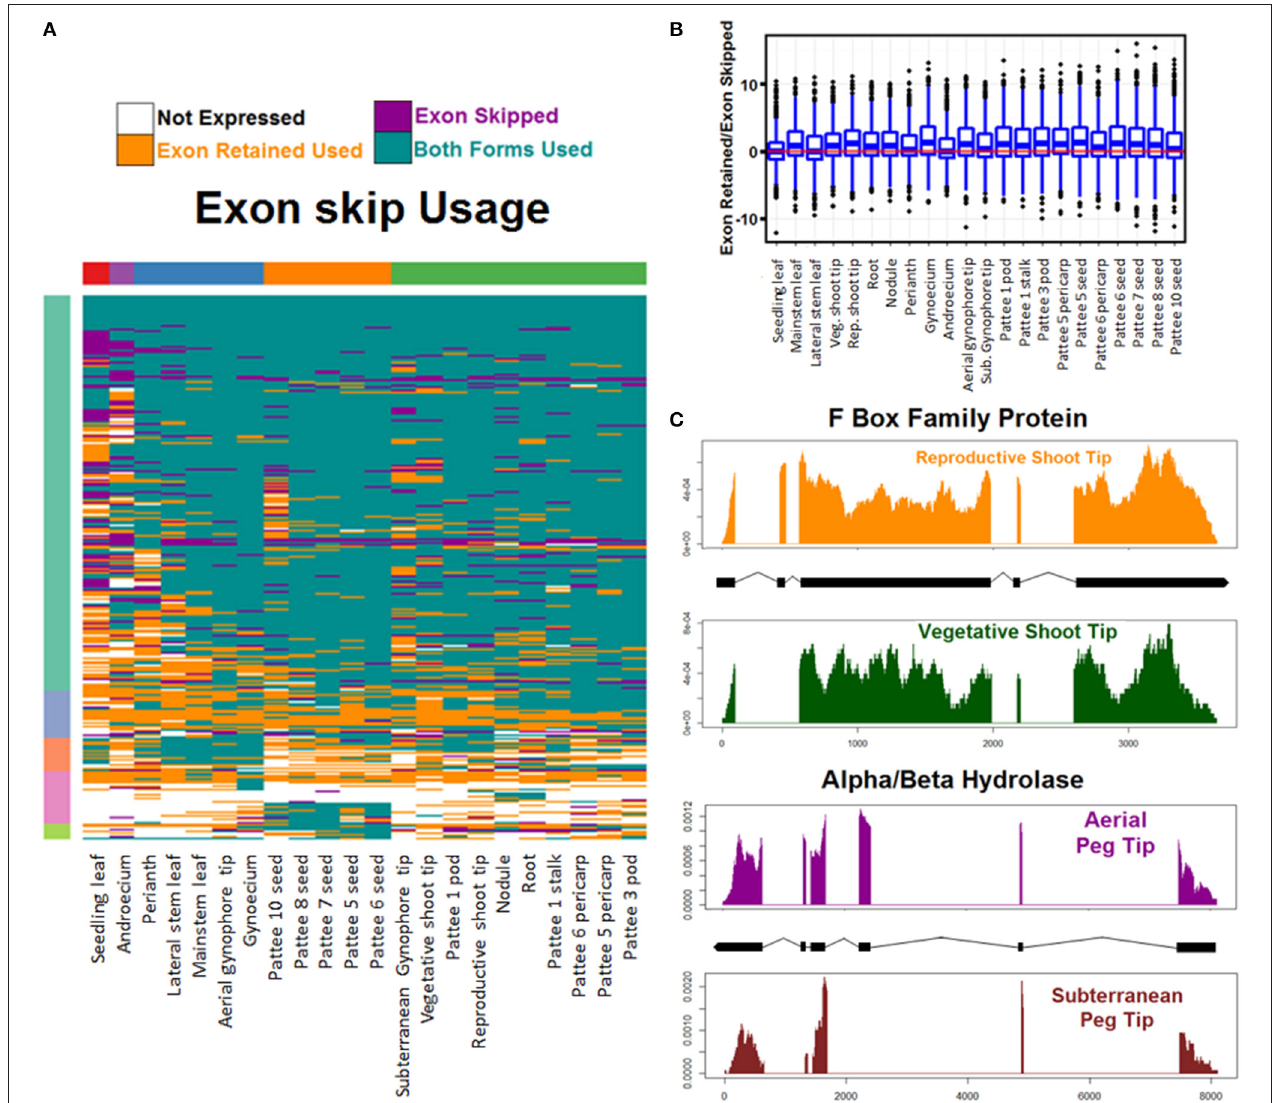
FIGURE 6 | Exon skipping alternative splicing (AS). (A) Hierarchical clustering of usage of exon skipping AS events. Tissues (columns) and events (rows) are clustered for Euclidean distance of exon skipping AS event usage. (B) Exon skipping usage preference. For each tissue and all exon skipping AS events the preference to either skip the exon or retain it is calculated as log2 (Reads showing exon retain/Reads showing exon skip). Balanced usage (0) is indicated with a red line. (C) Two examples of exon skipping AS preferential usage. Read coverage represented as read density of mapped reads/total reads mapped to transcript. X axis is base pairs of